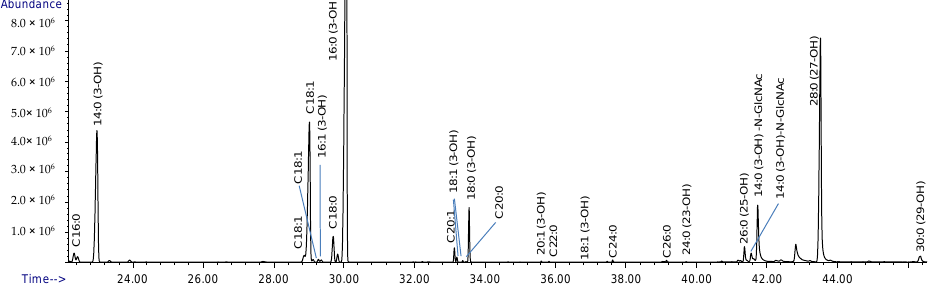
Figure 4. Composition analysis of the isolated lipid A from Lcr. LPS from Lcr was released by mild acid hydrolysis and preparation of TMS methyl glycosides. The fatty acid composition shows residues consistent with lipid A from Rhizobiaceae (28:0 (27-OH)), and the presence of 14:0 (3-OH) fatty acid amide linked to glucosamine.